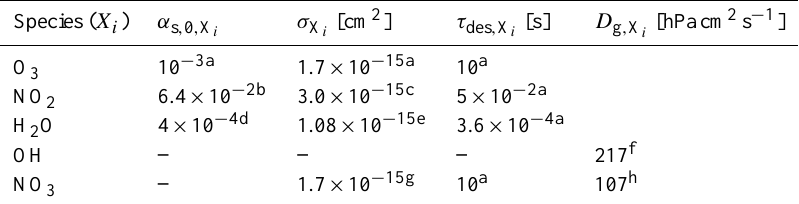
Table 3. Physico-chemical parameters for the species interacting with the soot surface in this